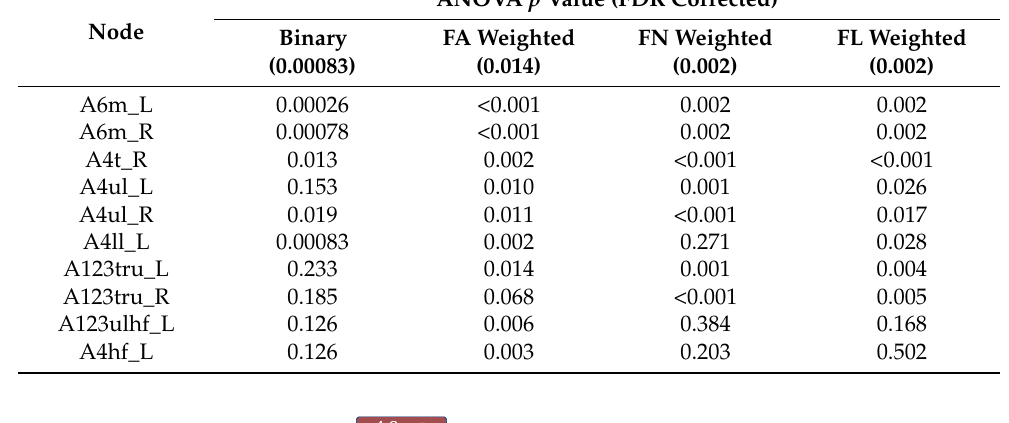
Table 4. Ten nodes that exhibited nodal efficiency difference.